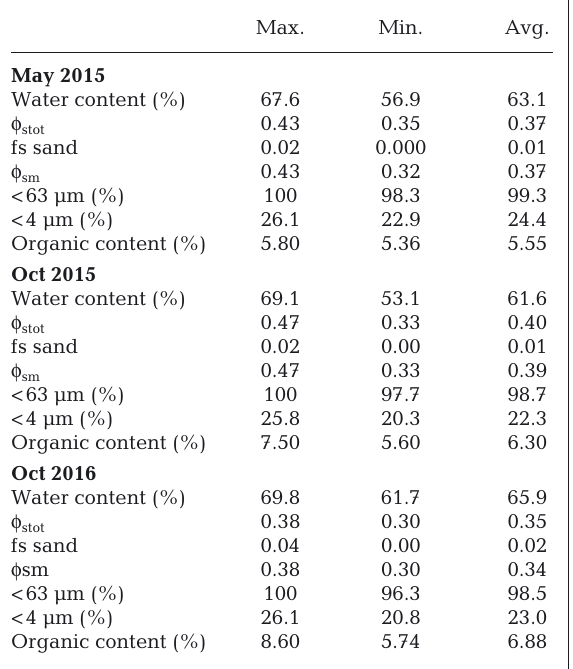
(Table 6). Post hoc analysis of interactions showed significant differences in CME only among the sta- tions at 0 and 1000 m.